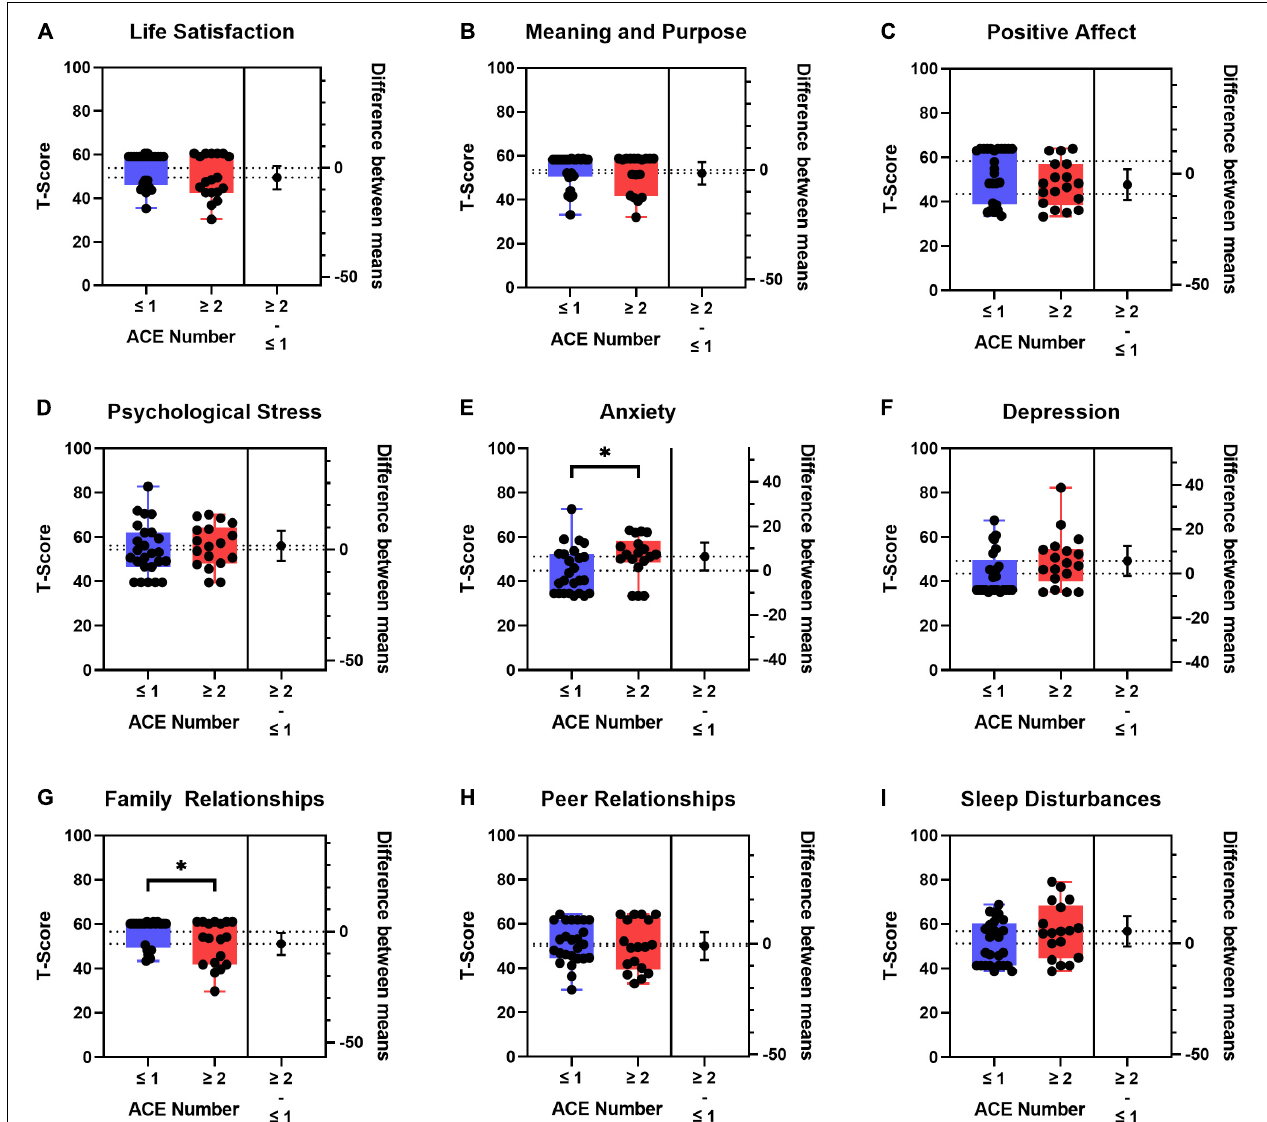
FIGURE 4 | Boxplots of patient reported outcome measures (PROMIS) T-scores and difference between means by ≤ 1 ( n = 25) vs. ≥ 2 ( n = 18) adverse childhood experiences (ACEs). (A) Life Satisfaction, (B) meaning and purpose, (C) positive affect, (D) psychological stress, (E) anxiety, (F) depression, (G) family relationships, (H) peer relationships, and (I) sleep disturbances. T -tests were used to compare differences between groups. Self-reported PROMIS T-scores were used preferentially in children who also had proxy-reported PROMIS T-scores. If no self-reported PROMIS T-score was available, the proxy-reported T-score was used. Blue boxes denote ≤ 1 ACE; red boxes denote ≥ 2 ACEs. The population normed T-score is 50 with a standard deviation of 10. The higher the T-score means that there is more of the concept you are testing. Dotted horizontal lines are the means for the two groups. The lower and upper edges of the boxplots are the 25th and 75th percentiles, respectively. The whisker lines are the minimum and maximum values. The black circle to the right of each boxplot is the difference between means for the two groups with the 95% CI denoted by the whisker line. ∗ p <